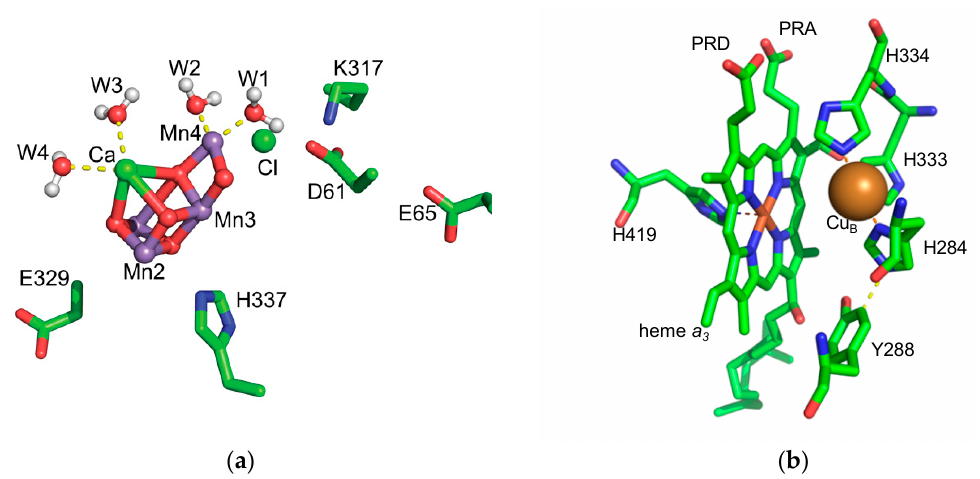
Figure 2. Structure of the active sites of PSII and CcO. ( a ) The Mn 4 CaO 5 cluster of the OEC. The water ligands to Mn4 and Ca II as well as the nearby residues D1-E329, D1-H337, D1-D61, D1-E65, D2-K317 and nearby Cl are shown. ( b ) The structure of the BNC in CcO. Cu B is the sphere. Heme a 3 , Y288 as well as the ligands of heme a 3 and Cu B are shown in sticks. Y288 is covalently bound to the Cu B ligand H284, PRD and PRA are the propionate acids of heme a 3 and may be part of the PLS. Substrate water will bind between Cu B and the central iron of Heme a 3 .